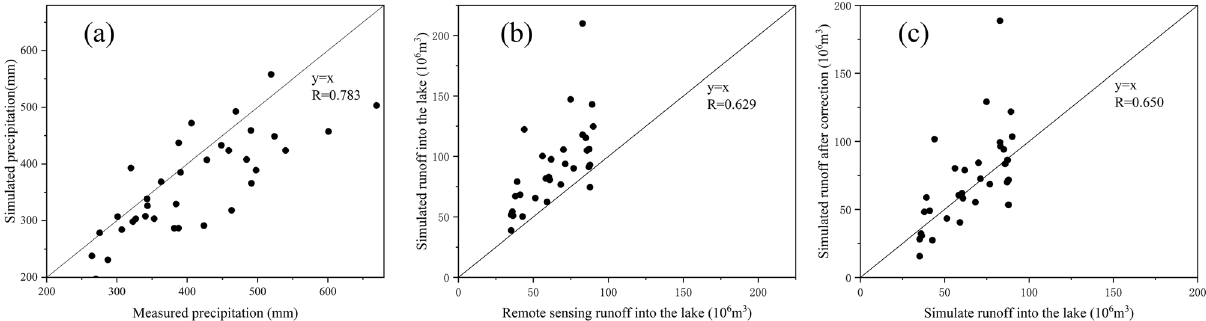
Figure 3. ( a ) Comparison between WRF-HYDRO simulation and measured annual precipitation in Daihai; ( b ) Comparison of runoff simulation and remote sensing estimation in Daihai Lake; ( c ) Modified runoff simulation and remote sensing estimation in Daihai